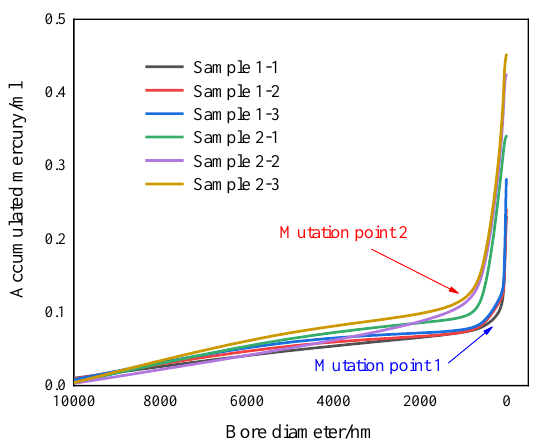
Figure 16. Volume distribution of different sample pore diameters and cumulative mercury intake.